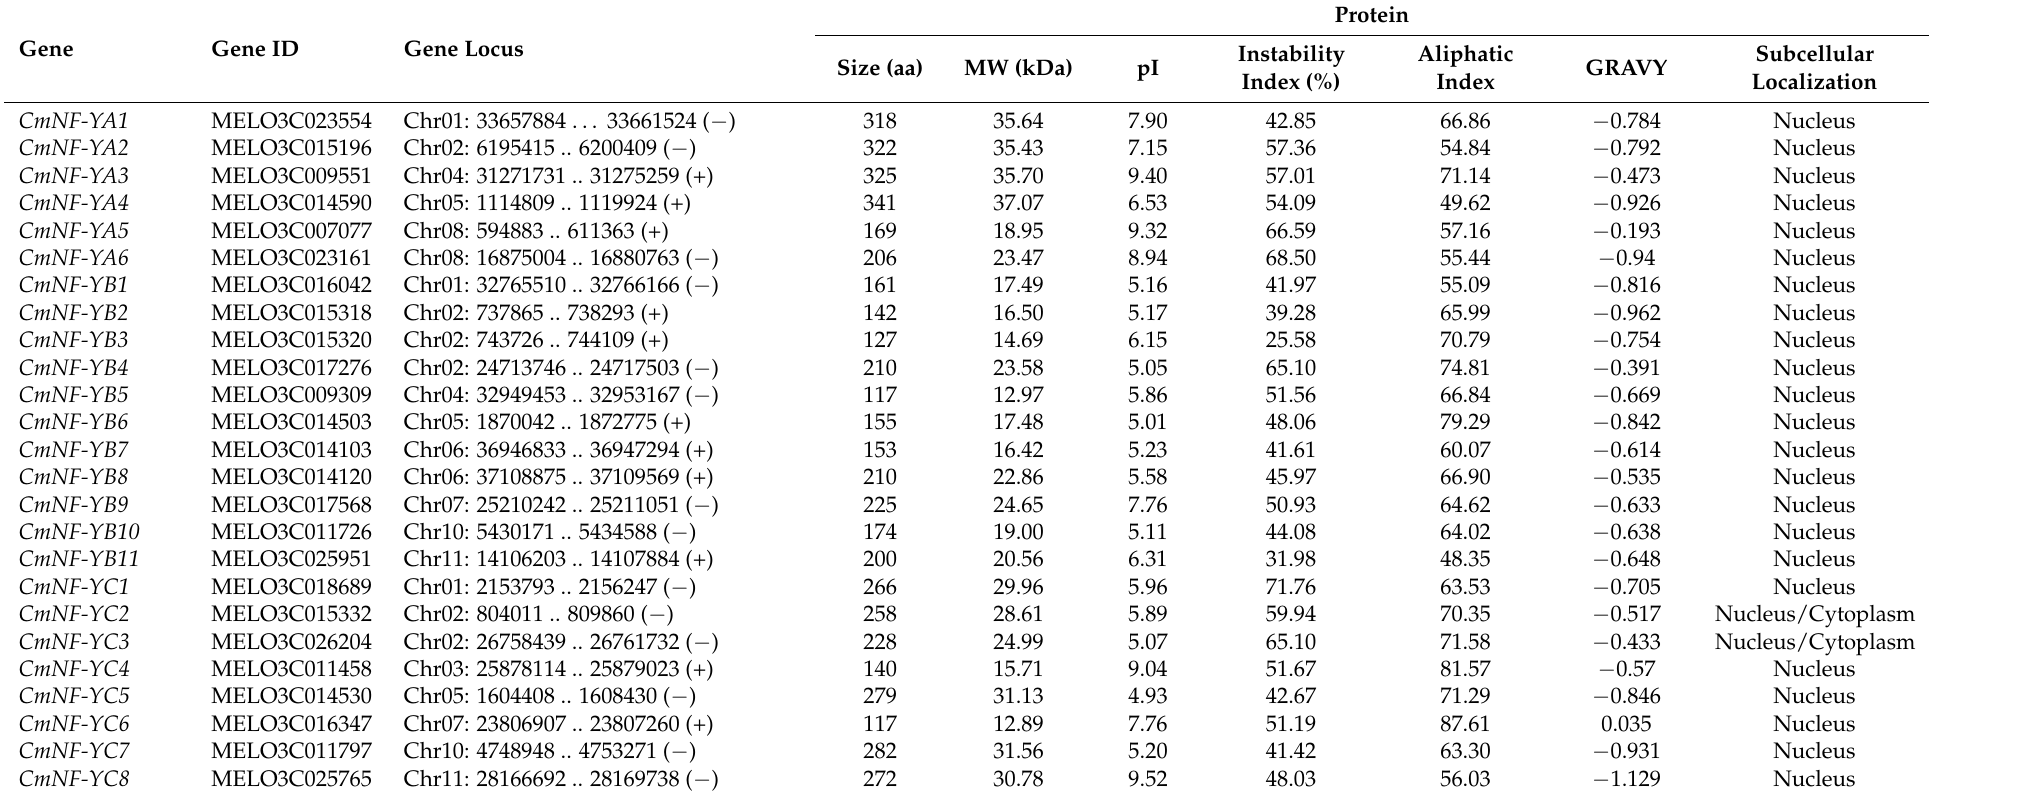
Table 1. Identification of the CmNF-Ys gene family in